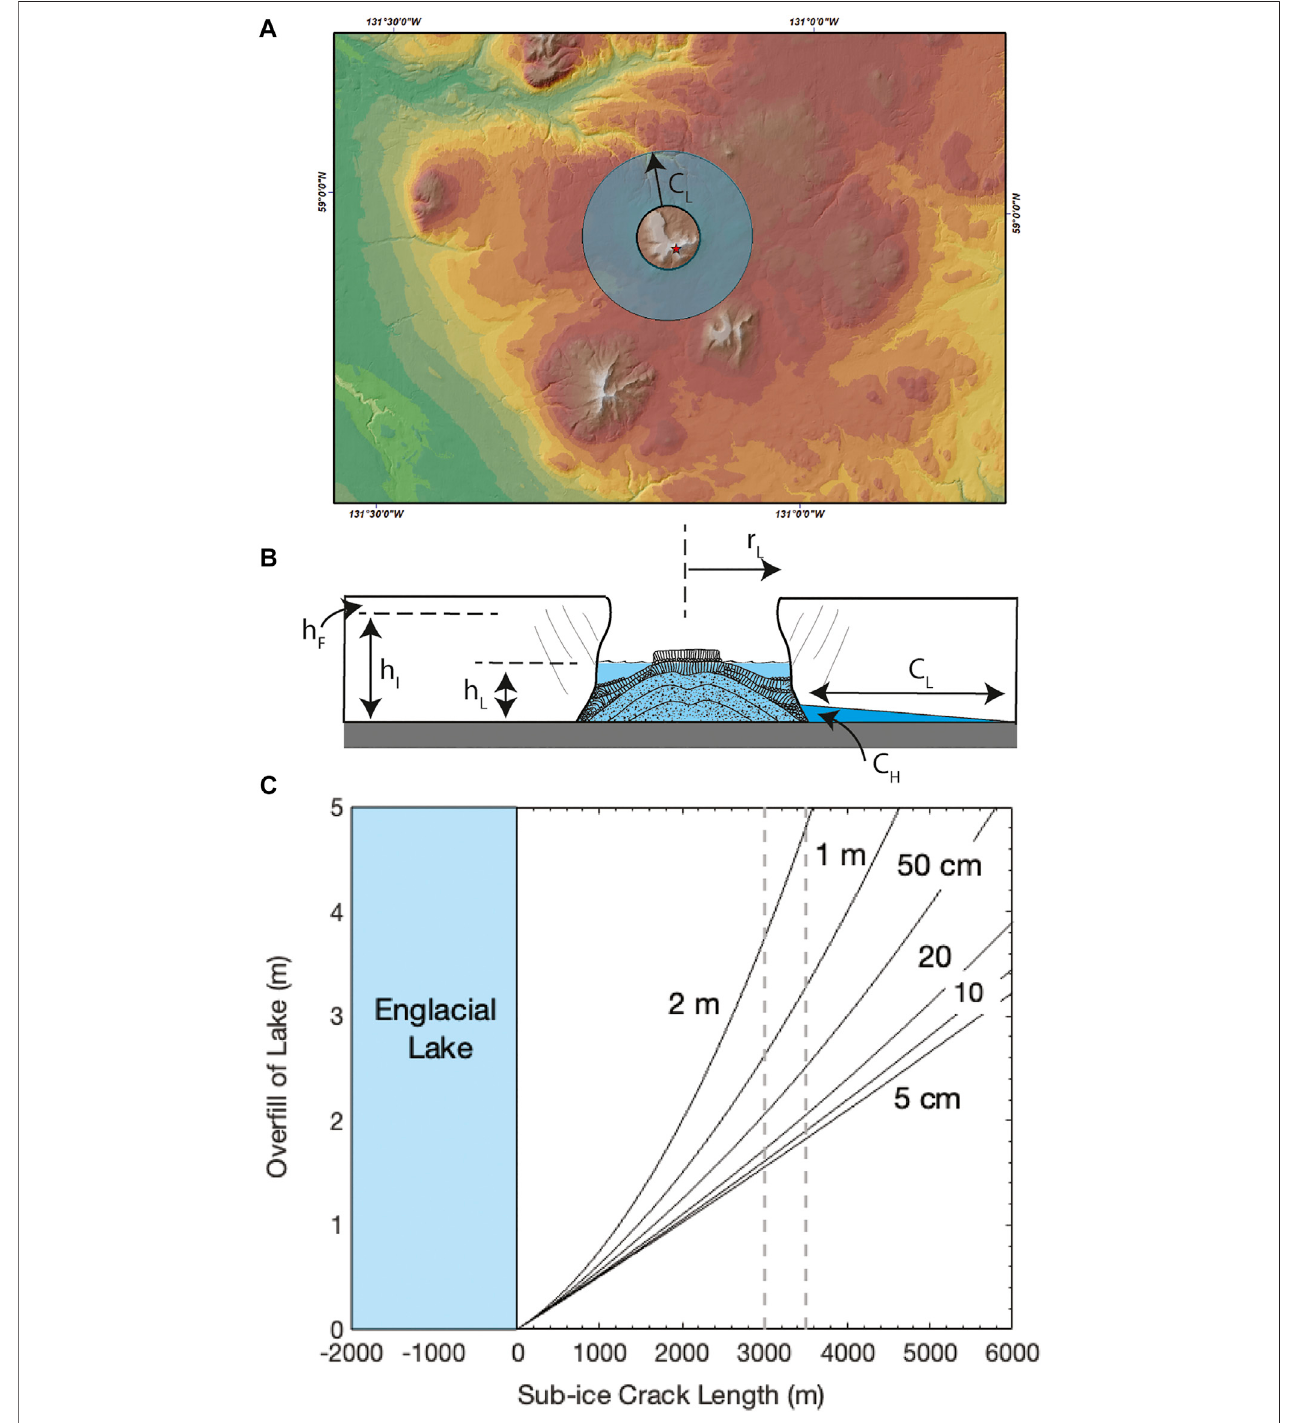
FIGURE 9 | Model for growth and radial propagation of sub-ice crack linked to major drainage systems driven by over fi lling of syn-eruptive englacial lake. (A) Geometric sketch of model for predicting length ( CL ) of sub-ice wedge-shaped cracks as a function of ice and lake dimensions. (B) Model values of crack length versus over fi ll of lake above an equilibrium depth and contoured for the maximum opening of the crack near the englacial lake. (C) The major drainages on the Kawdy plateau surrounding the Kima Kho volcano are less than 3 – 3.5 km from the vent. The model curves show that very slight rises in lake level would be capable of supporting openingand propagation ofsub-icecracksthatintersect thosedrainages. Conservative initialcrackopenings of10 – 20 cmwould fi ndsuch drainageswithonly a1 – 2 m rise in lake level over its equilibrium height.